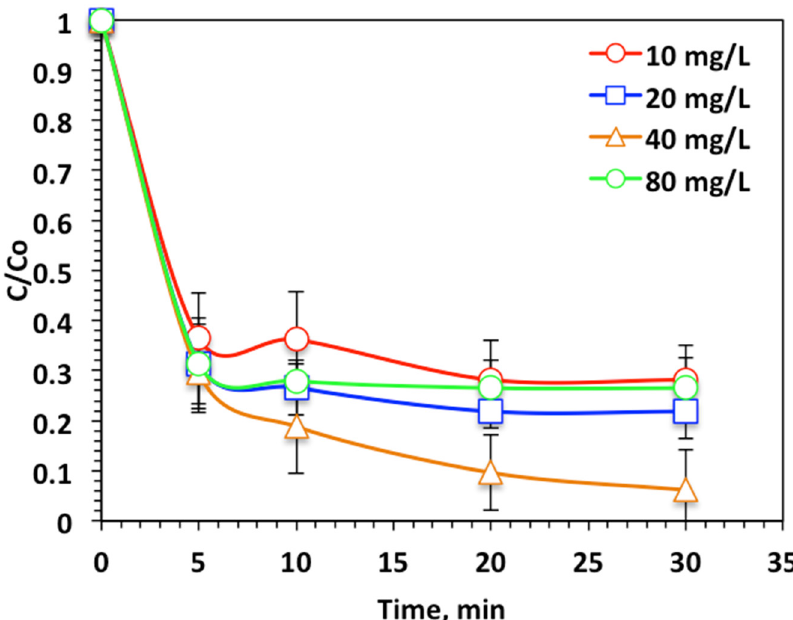
Figure 7. Effect of WSD:Mag loading on photo-Fenton-like oxidation-based WSD:Mag system. Effect of pH Value